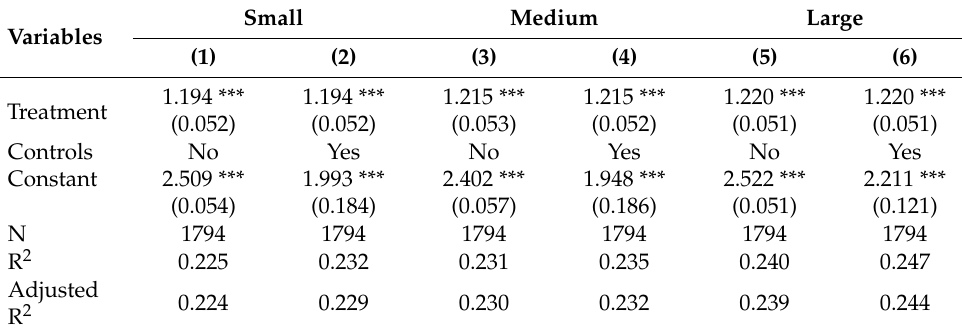
Table A2. The effect of the three scales of intervention on tourists’